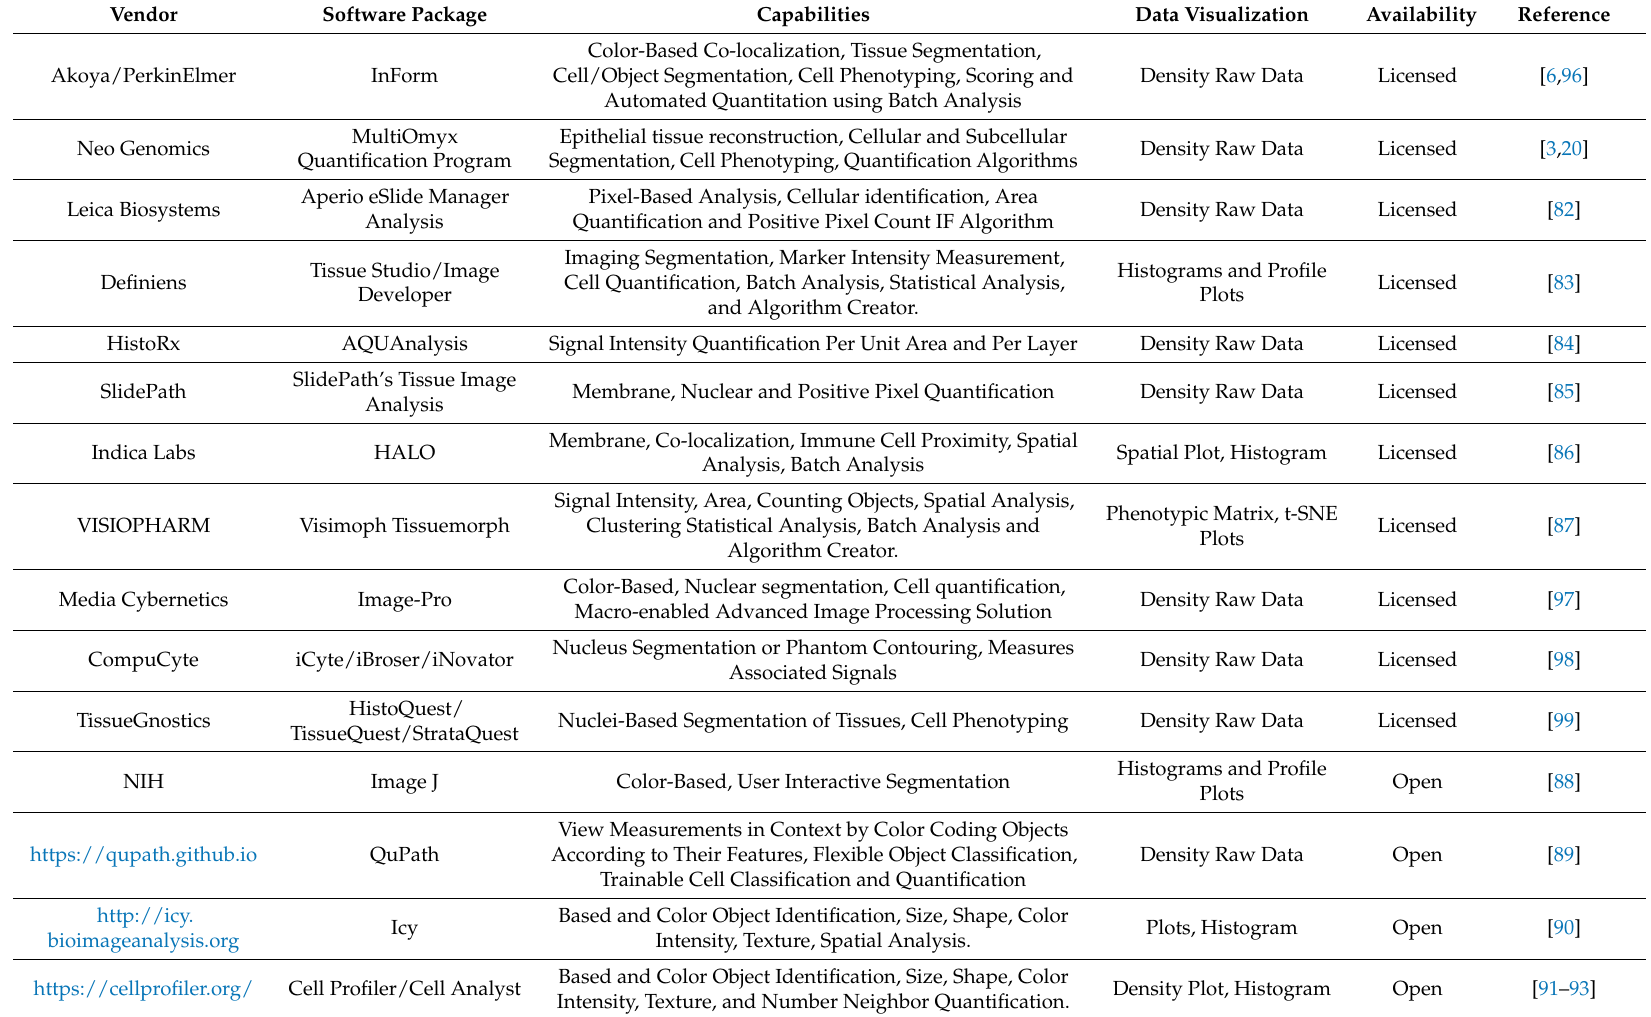
Table 2. Image analysis software packages for multiplex